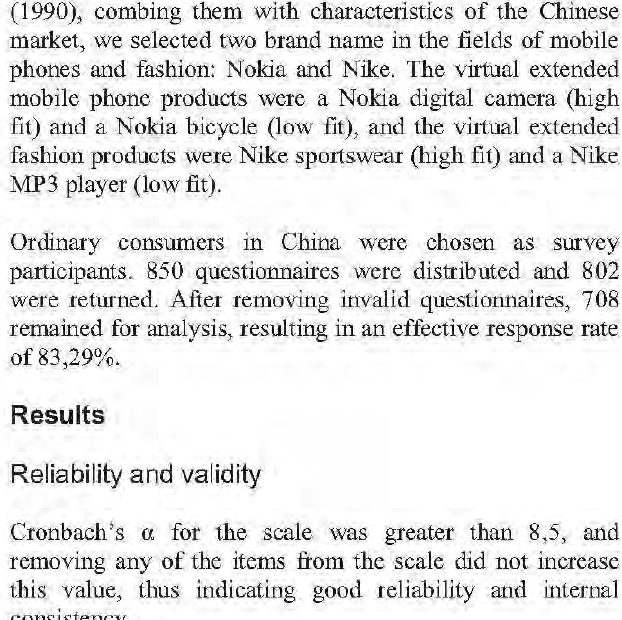
Figure 1: Conceptual model